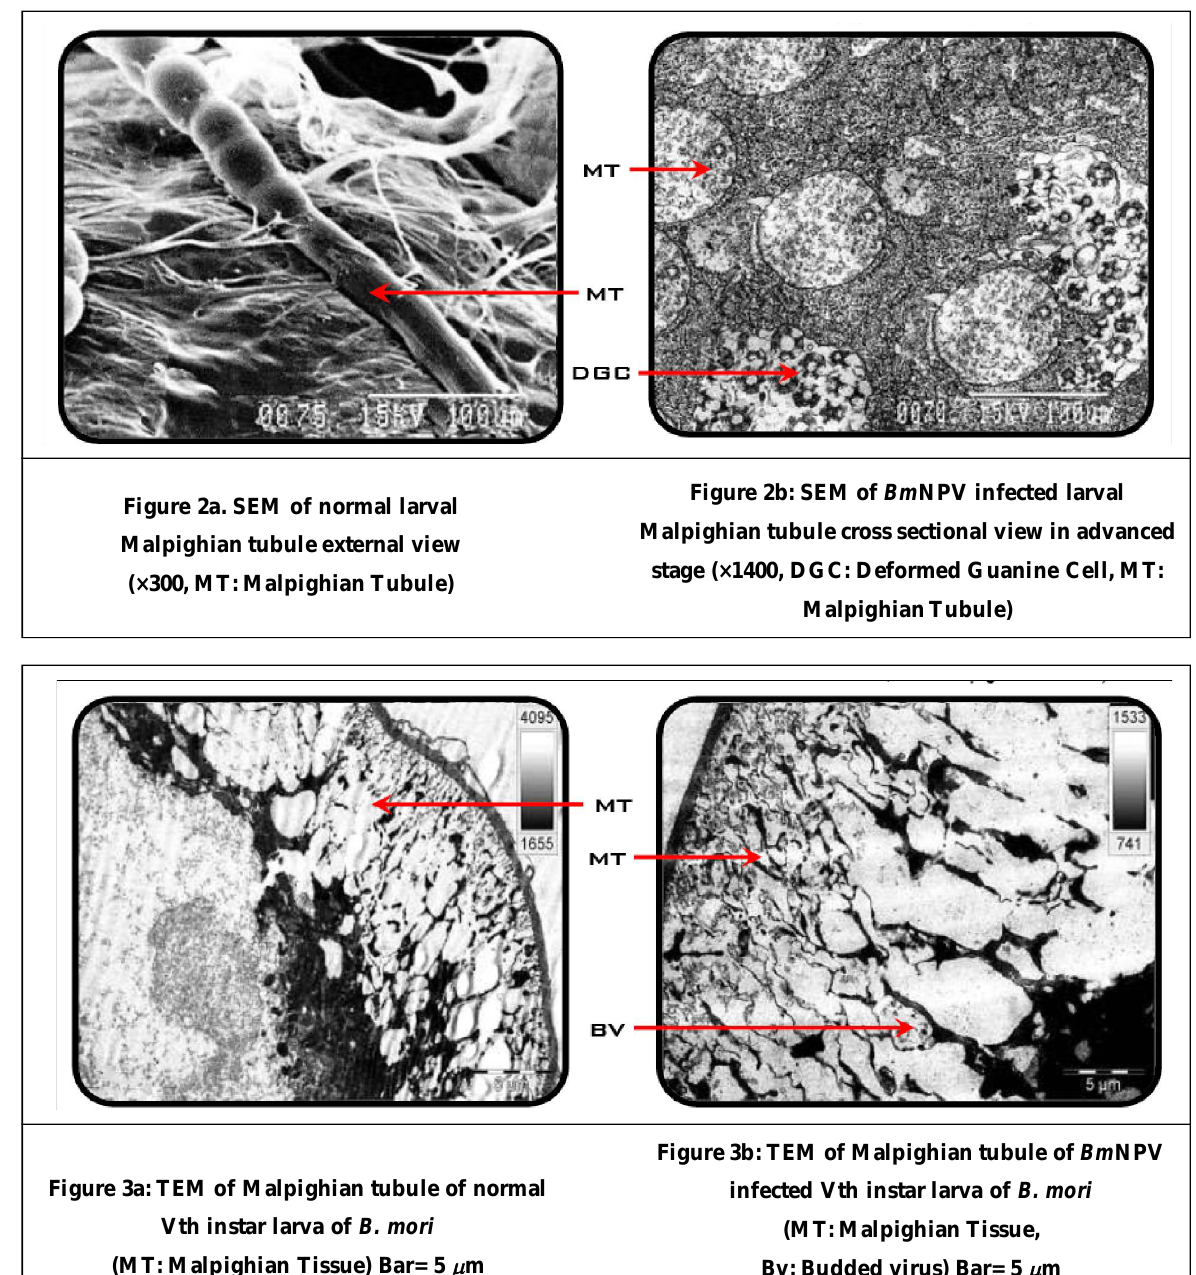
Figure 3a: TEM of Malpighian tubule of normal Vth instar larva of B. mori (MT: Malpighian Tissue) Bar= 5  m